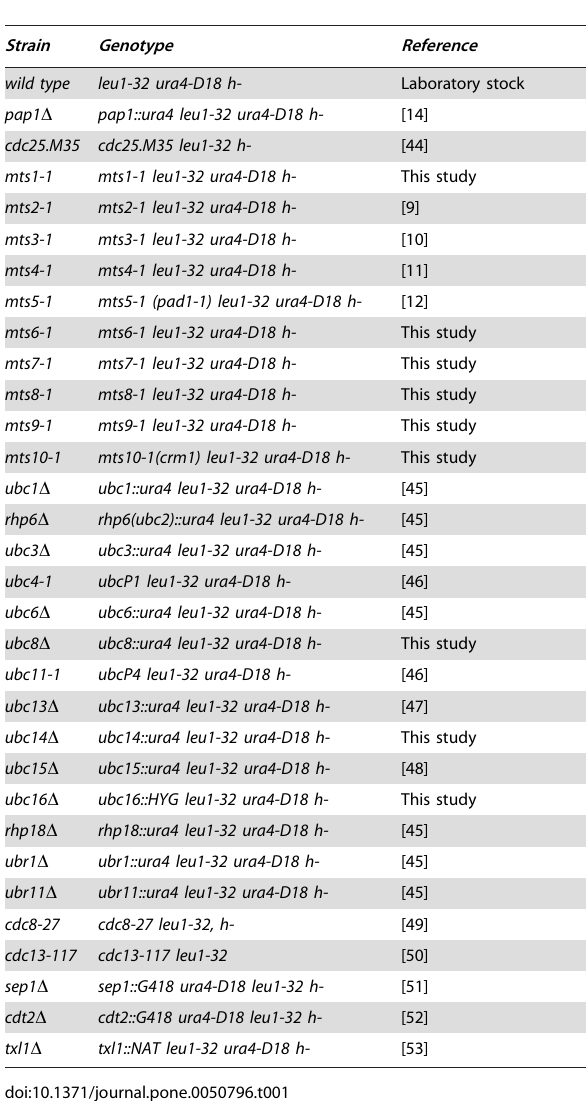
Table 1. Fission yeast strains used in this study.